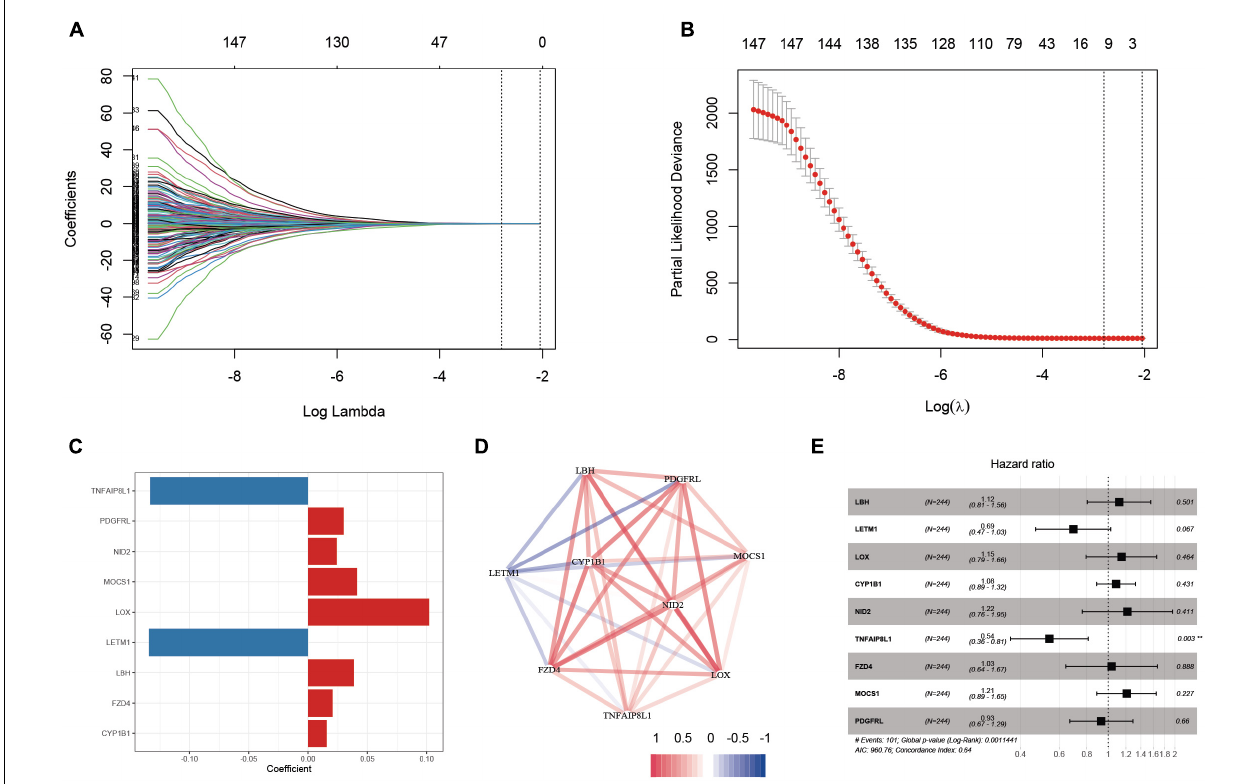
FIGURE 5 | Establishment of an hsa-miR-100-5p-related prognostic signature. (A) The changing trajectory of each variable in LASSO Cox regression. (B) Selection of the optimal lambda value. (C) The coefficients of nine selected genes. (D) Co-expression network of selected genes. (E) Multivariate Cox analysis of nine selected genes based on the training cohort. ** p <